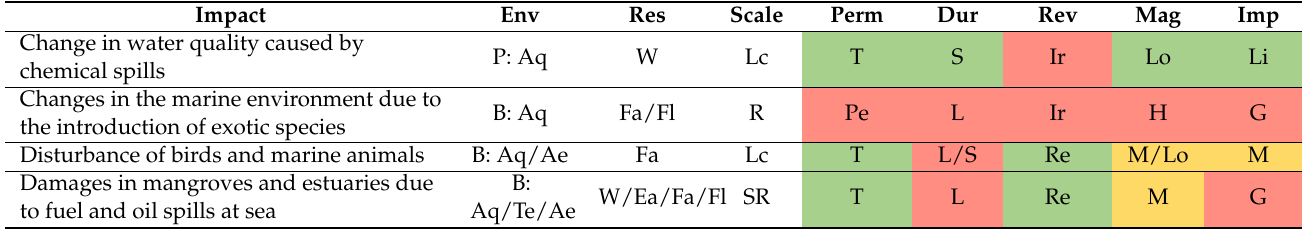
Table 10 lists the relevant potential environmental impacts that can be caused during Stage 2. The key is as follows: Environment (Env): Biotic (B) or Physical (P), Aquatic (Aq), Terrestrial (Te), Aerial (Ae); Resource (Res): Fauna (Fa), Flora (Fl), Air (Ar), Earth (Ea); Water (W); Scale: Local (Lc), Regional (R), Superregional (SR); Permanence (Perm): Temporary (T), Permanent (Pe); Duration (Dur): S, M, L; Reversibility (Rev): Re, PR, Ir; Magnitude (Mag): Lo, M, H; Importance (Imp): Li, M, G. Created based on